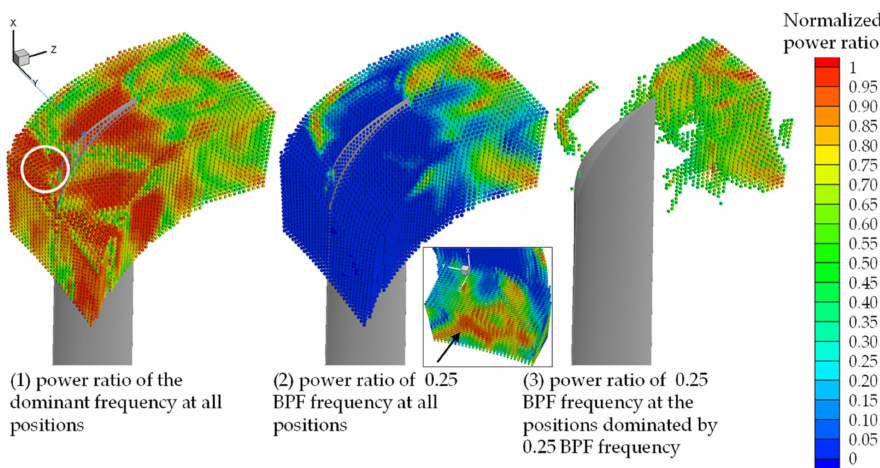
Figure 22. Power ratio analysis of close_C.